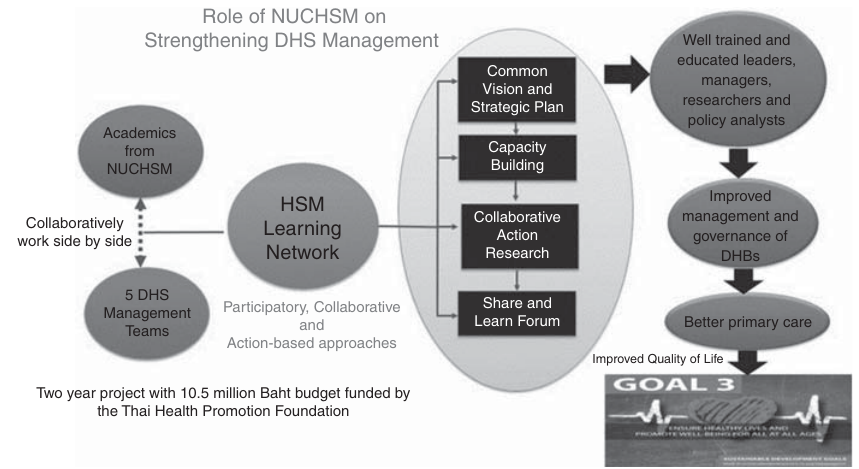
Figure 5. Role of